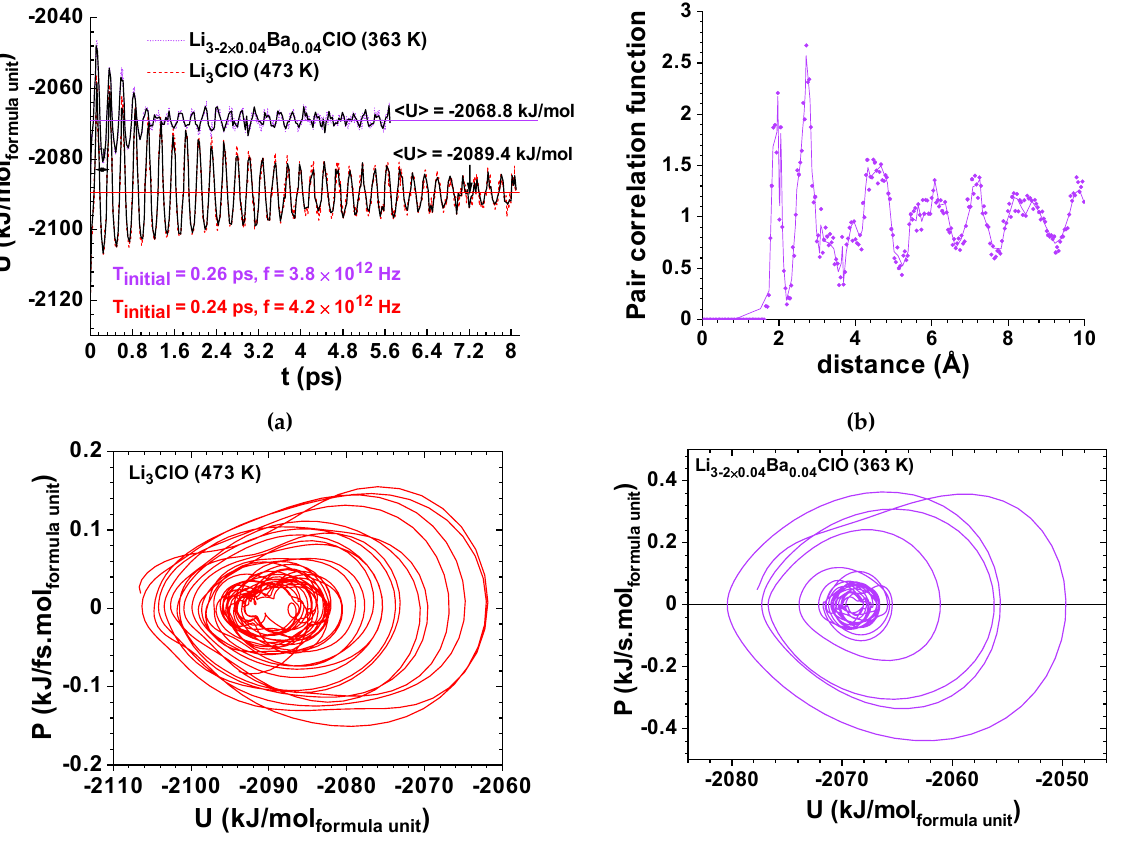
Figure 5. Ab Initio Molecular Dynamics for Li-glass ferroelectric-electrolytes; ( a ) potential energy vs time for Li 2.92 Ba 0.04 ClO and Li 3 ClO. The upper envelope energy for Li 2.92 Ba 0.04 ClO at 363 K before decoherence: − 2085 + 41.94 e − t /5.634 kJ/mol formula unit corresponding to a damping oscillator; decoherence is observed above 1.2 ps; the calculated specific heat is C v’ = 0.193 kJ/kg K; the upper envelope energy for Li 3 ClO at 473 K before decoherence: − 2085 + 30.23 e − t /2.012 kJ/mol formula unit corresponding to a damping oscillator; decoherence is observed above 7 ps; the calculated specific heat is C v’ = 0.465 kJ/kg K; ( b ) pair correlation function for Li 2.92 Ba 0.04 ClO, at 363 K, showing first and second neighbors at fixed distances corresponding to sharp peaks and broad peaks for third and above neighbors’ distances indicating structural disorder, often associated with an amorphous character, as expected from experimental results; ( c ) phase portrait for power vs. energy for Li 3 ClO at 473 K corresponding to a damped coherent oscillator that becomes decoherent; the relaxation of the focus (equilibrium energy) corresponds to a variation of 0.3% from the initial focus energy; ∆ U max = U max − U min ≈ 0.46 eV; ( d ) phase portrait for power vs energy for Li 2.92 Ba 0.04 ClO, at 363 K, corresponding to a damped coherent oscillator that becomes decoherent; the relaxation of the focus corresponds to a variation of 0.2% of the initial energy; ∆ U max ≈ 0.32 eV. Note: both ( b ) and ( c ) are similar to the Duffing oscillator model in Figure